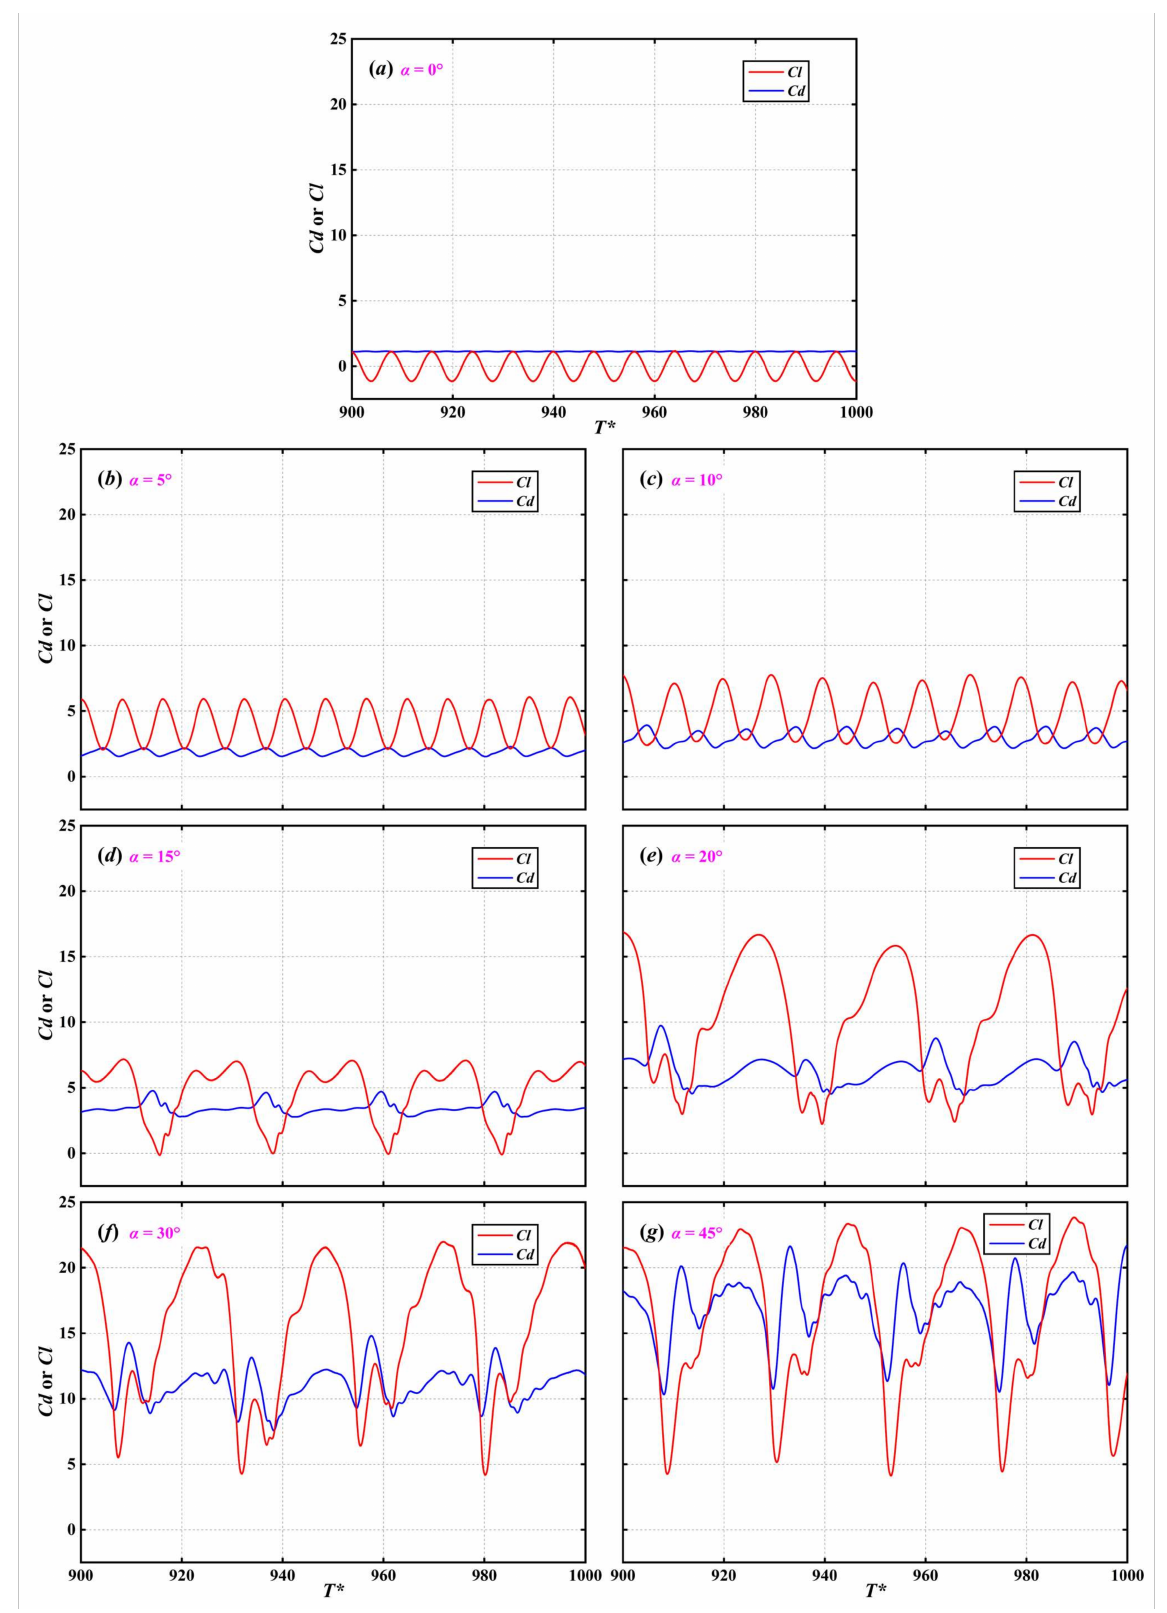
Figure 7. Time histories of lift coefficient and drag coefficient under different AoAs. ( a ) α = 0 ◦ , ( b ) α = 5 ◦ , ( c ) α = 10 ◦ , ( d ) α = 15 ◦ , ( e ) α = 20 ◦ , ( f ) α = 30 ◦ , ( g ) α = 45 ◦